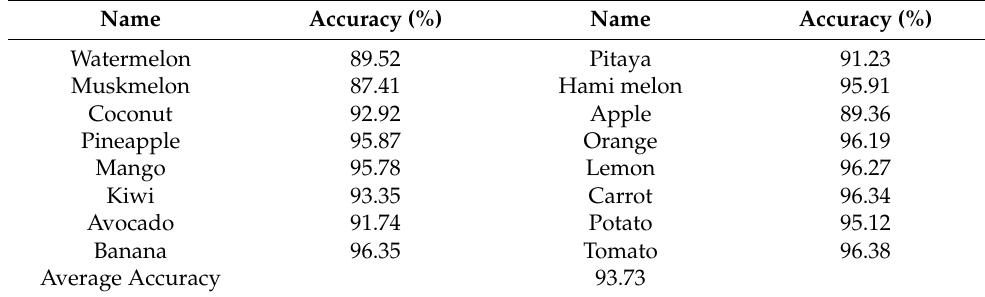
Figure 18. Identification test of single variety products. ( a ) Experimental environment; ( b ) the user interface after successful identification. Table 4. The accuracy of product